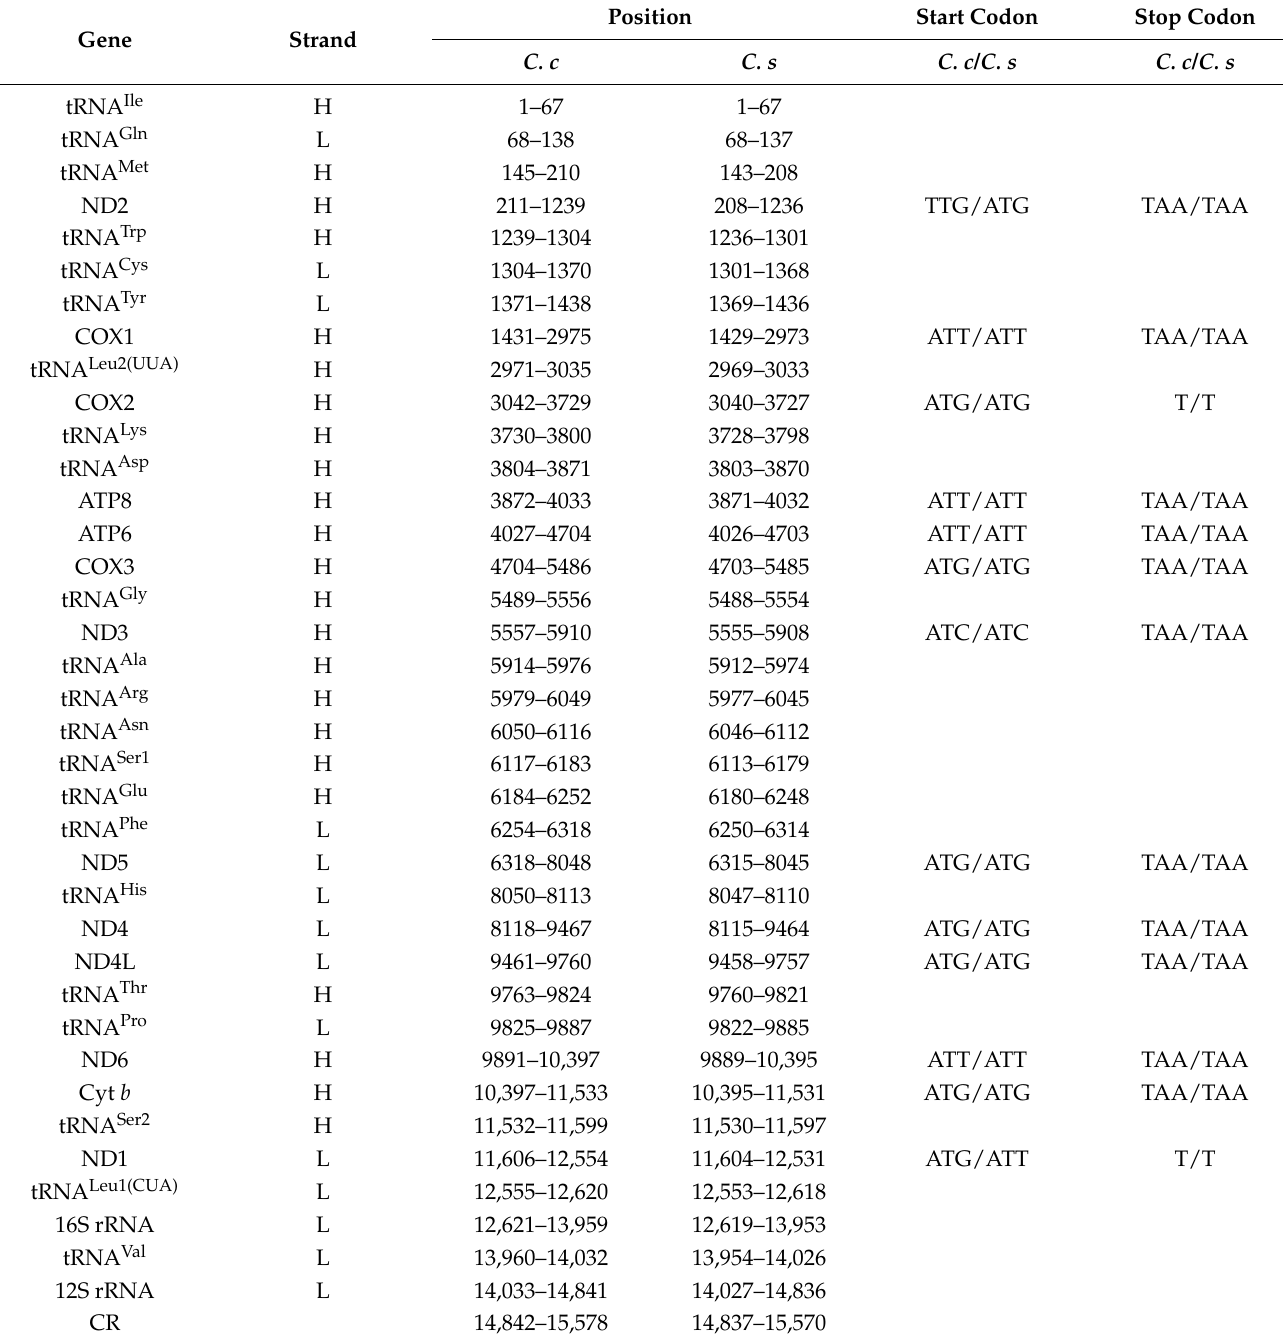
Table 3. Gene arrangement of C. coreanus ( C. c ) and C. songi ( C. s ) mitochondrial